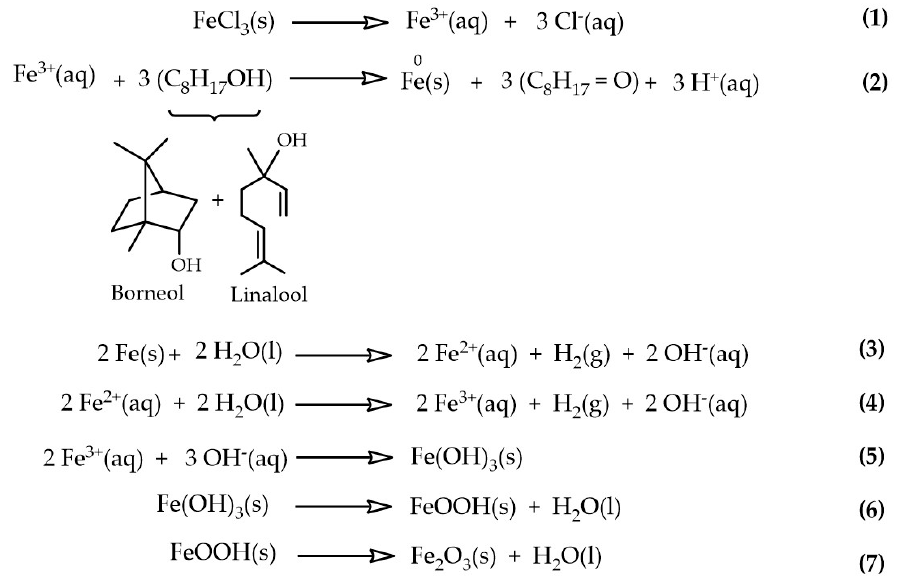
Figure 9. Proposed mechanisam of the synthesis pathway of hematite NPs by monoterpenoids. After dilution of the precursor (FeCl 3 ) (1) , the ferric cations are reduced by the monoter- penoids of the essential oil, and elemental iron is formed (2) . After hydration, ferric cations are formed (3) , (4) , and ferric hydroxide is precipitated (5) . The ferric hydroxide is dehy-